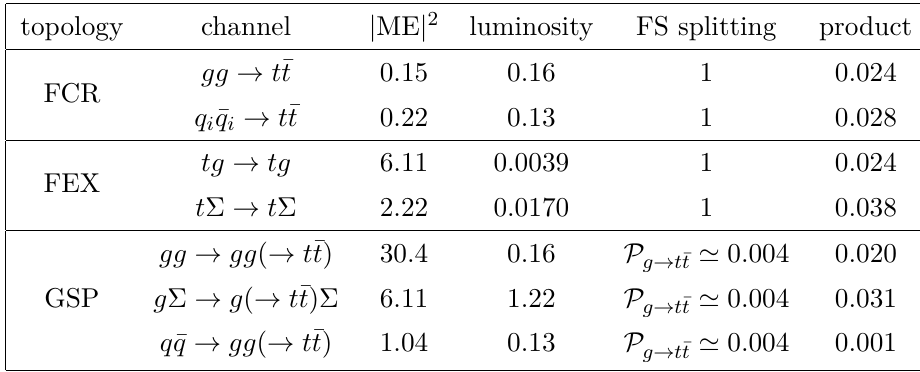
Table 2 . Factors contributing to the top-production cross section for a variety of partonic scattering channels. In each case the 2 → 2 squared matrix element ( | ME | 2 , with a g 4 = (4 πα ) 2 factor s stripped off as in eqs. (2.5), (2.6)) is given in the massless limit (valid when p ), for 90 ◦ T (cid:29) m t scattering in the partonic centre-of-mass frame. The partonic luminosities, defined as in eq. (A.2), √ are given for a proton-proton centre of mass energy of s = 13 TeV and for producing a partonic √ system mass of ˆ s = 2 TeV . We set the factorisation scale to µ = 1 TeV . Σ denotes a sum over all (non-top) quark and anti-quark flavours. The luminosities have been evaluated with the PDF4LHC15_nnlo_mc [28] set, re-evolved in a six-flavour scheme with HOPPET [29] using NNLO splitting and threshold-matching functions [30–33]. The final-state splitting probability P is g → t ¯ t obtained using eq. (2.9). The results in the final column are to be taken as order of magnitude estimates, illustrating the commensurate sizes of different